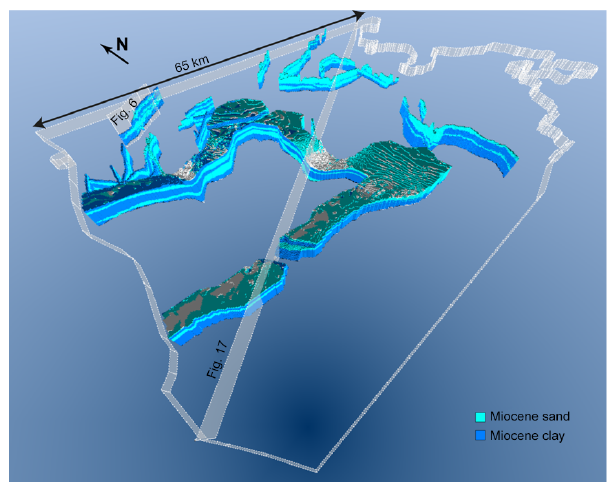
Figure 7. Three-dimensional view of the hard conditioning data (the buffer zone around the Tønder model and the seismic lines), seen from south-west. Positions of the seismic line in Fig. 6 and the profile in Fig. 17 are marked in the figure. Vertical exaggeration = 10 ×